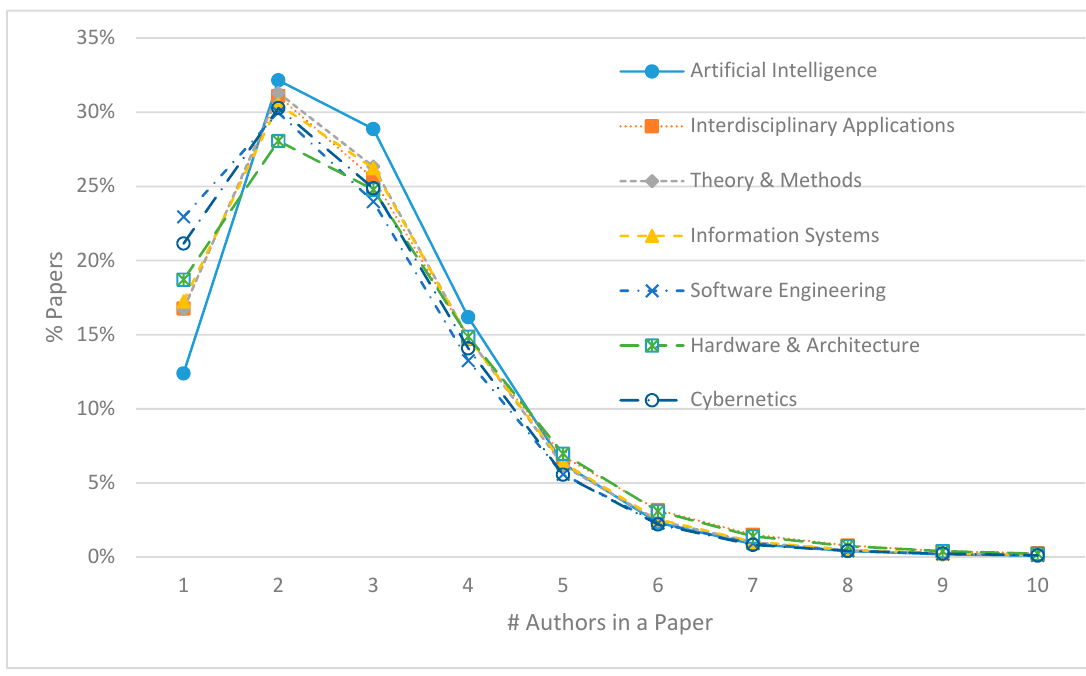
Figure 2. Distribution of the number of authors in papers in different subject categories.